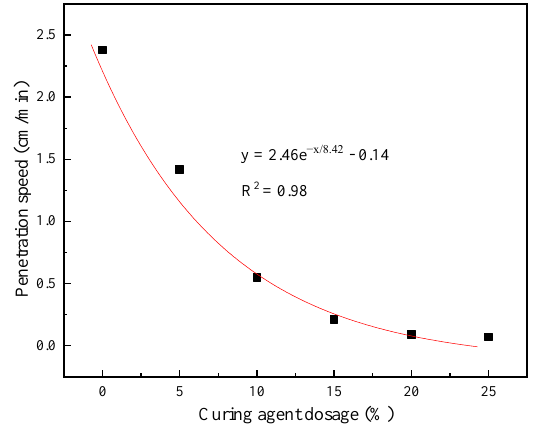
Figure 7. Relationship between the curing agent content and penetration